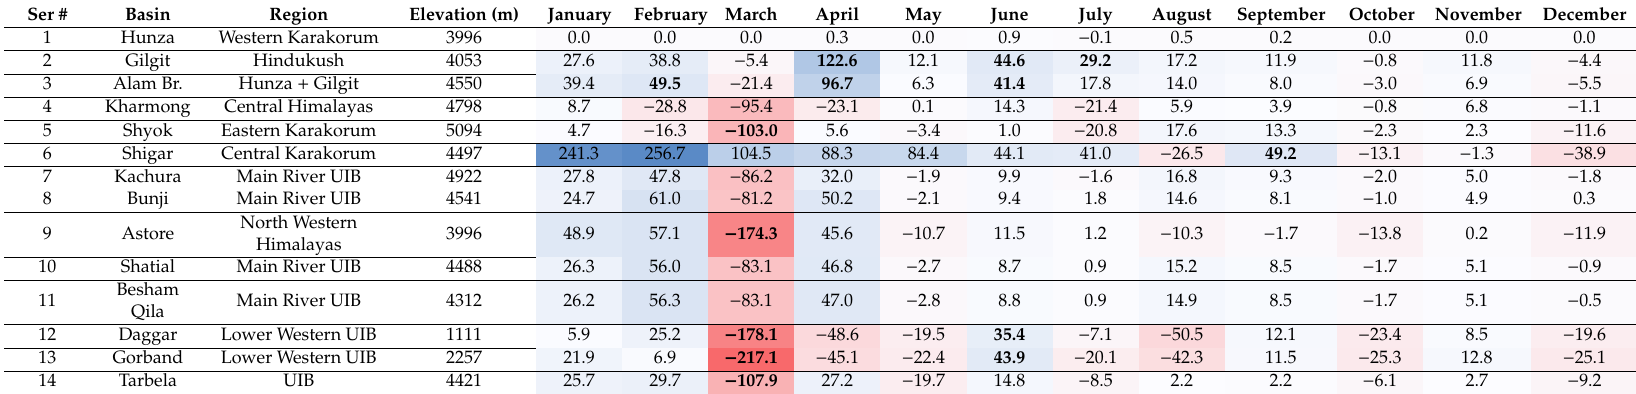
Table 8. Total changes in monthly precipitation (mm) extracted from the grid data for the Upper Indus Basin (UIB) from 1981 to